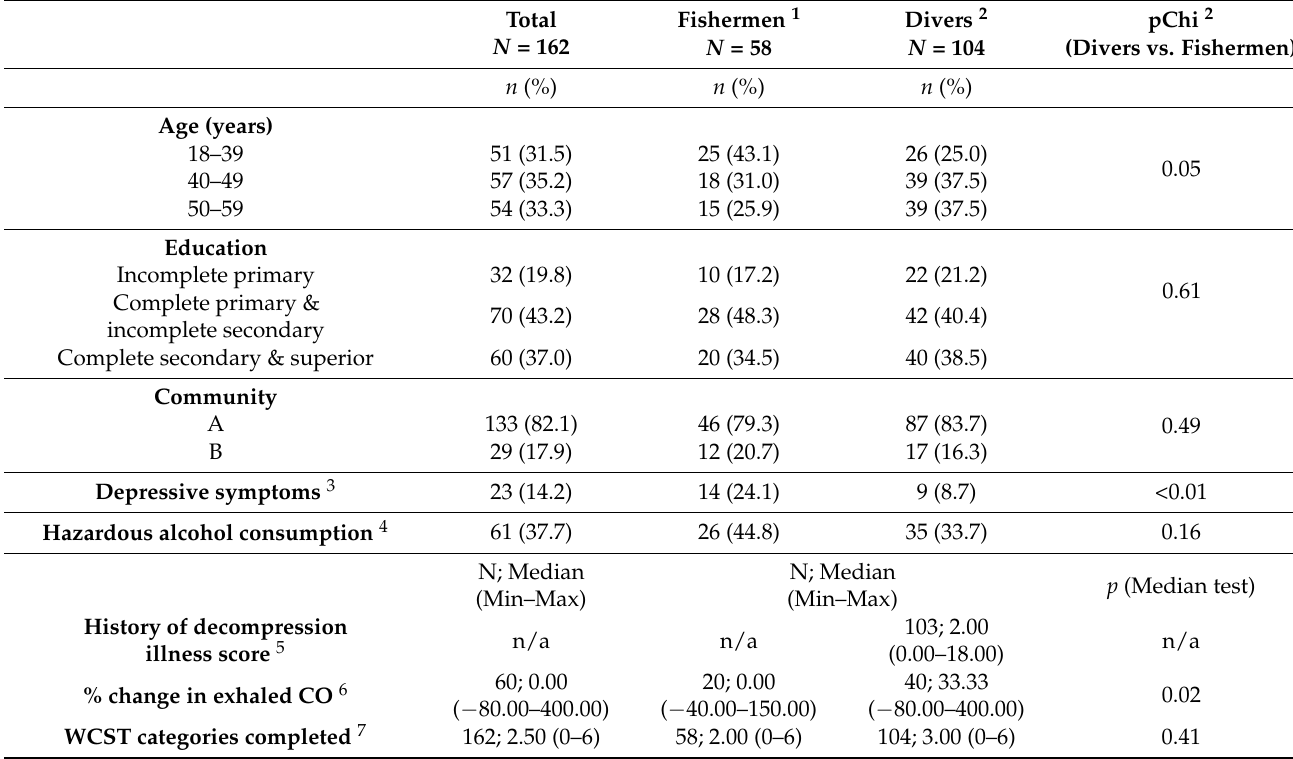
Table 1. Comparison of socio-demographics, potential confounders, variation in percentage of exhaled CO, decompression sickness score, and Wisconsin Card Sorting Test between fishermen and divers.